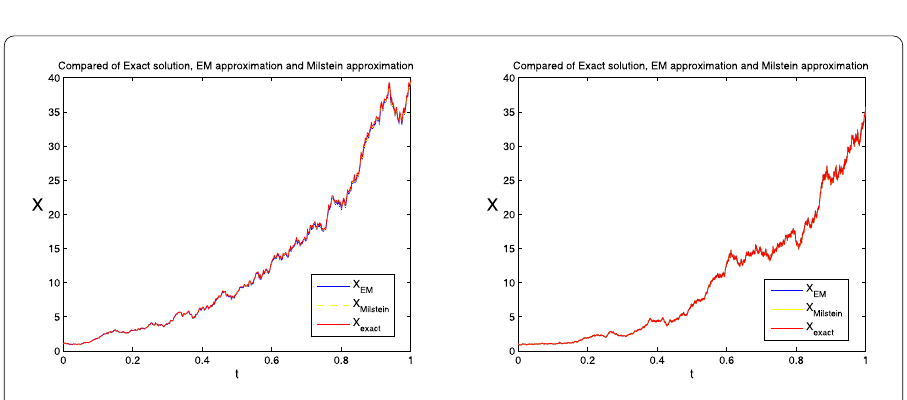
Figure 3 EM, Milstein approximation and exact solution for one sample paths and 2 9 , 2 13 discretization, respectively.